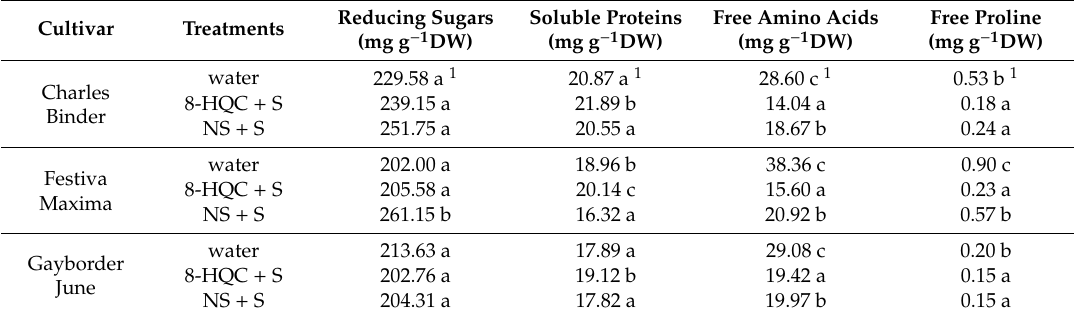
Table 4. The e ff ect of preservatives on biochemical changes in cut peony flowers. Cultivar